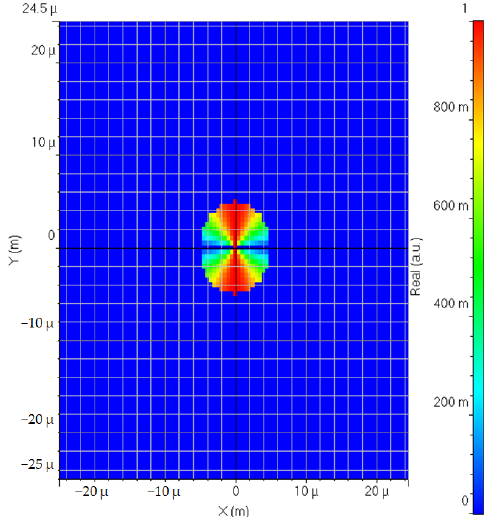
Figure 4. Generated donut mode 1 in MDM-PON system.